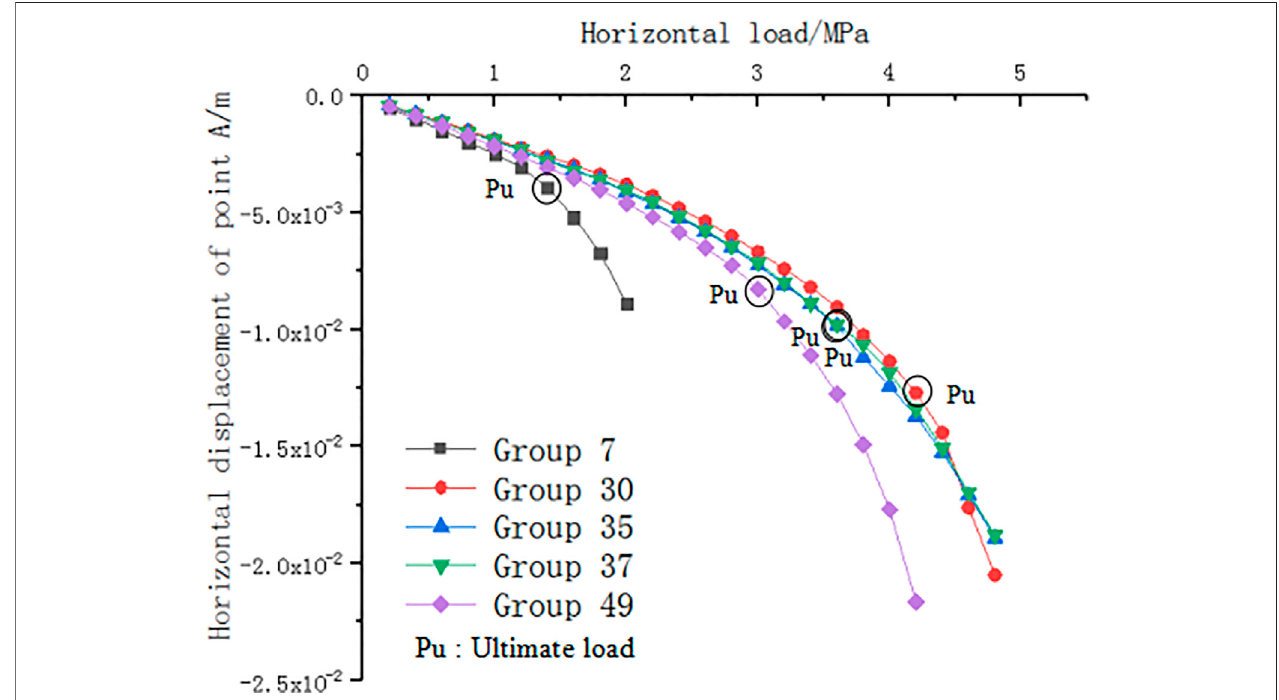
FIGURE 4 | Load displacement curves in the fi ve group